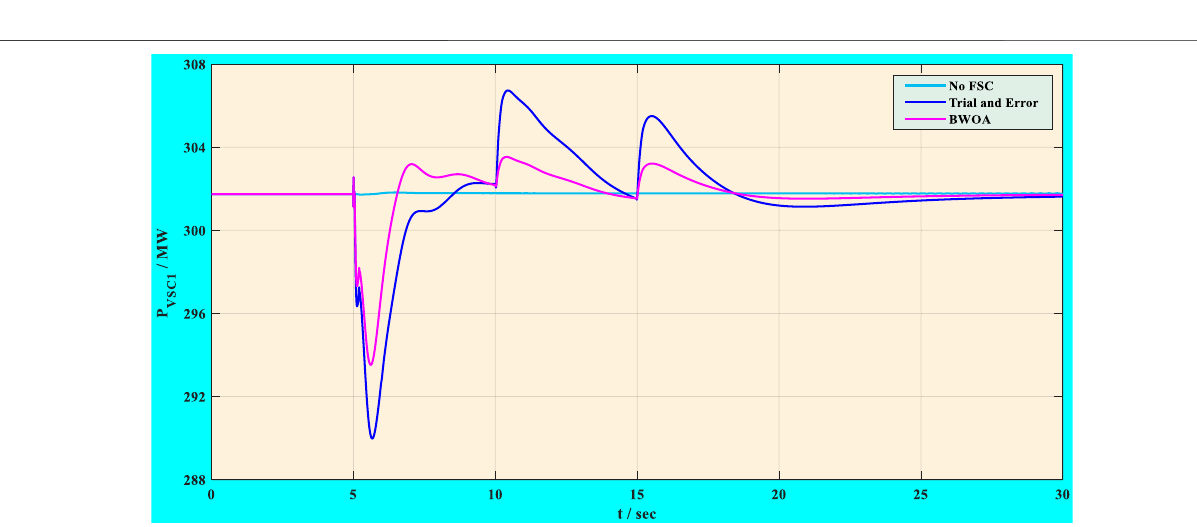
FIGURE 8 | Transmitted active power of VSC1 acquired by different methods under a 50-MW load decrease.